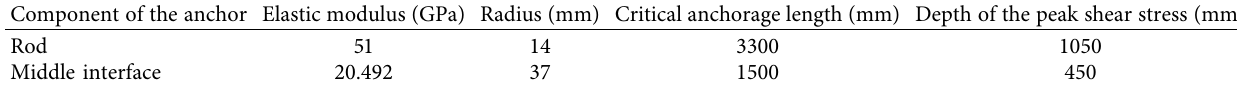
Table 3: Calculation parameters of the anchors G-28-6.5 and